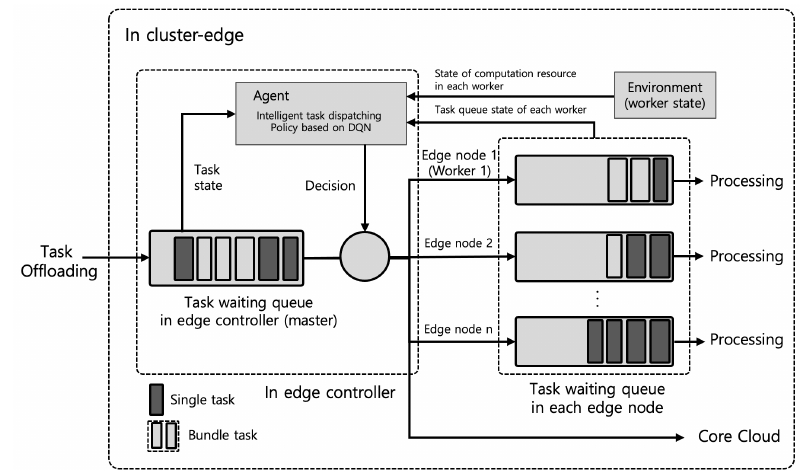
Figure 2. DRL-based intelligent task dispatching method (DDM) using DQN in the cluster